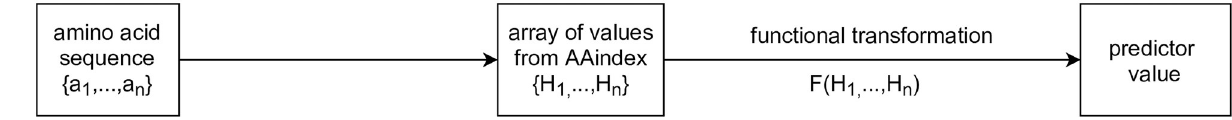
Fig 4. Generation of predictors based on physico-chemical properties of amino acids comprising a protein fragment, schematic representation.